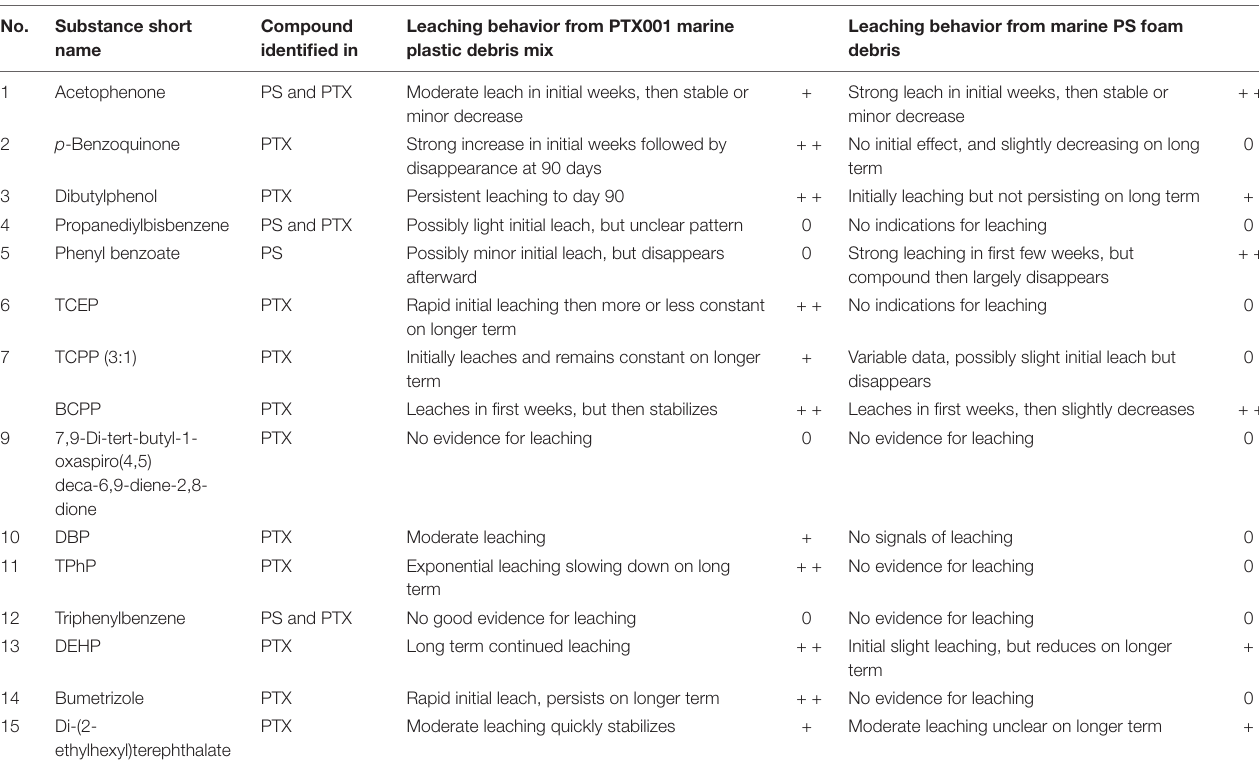
TABLE 2 | Summary of the leaching results for different substances detected in marine litter-derived microplastic reference mixture (PTX001) and marine litter-derived polystyrene foam (PS) to stomach oil of northern fulmars (0 = no, + moderate, + + strong leaching).